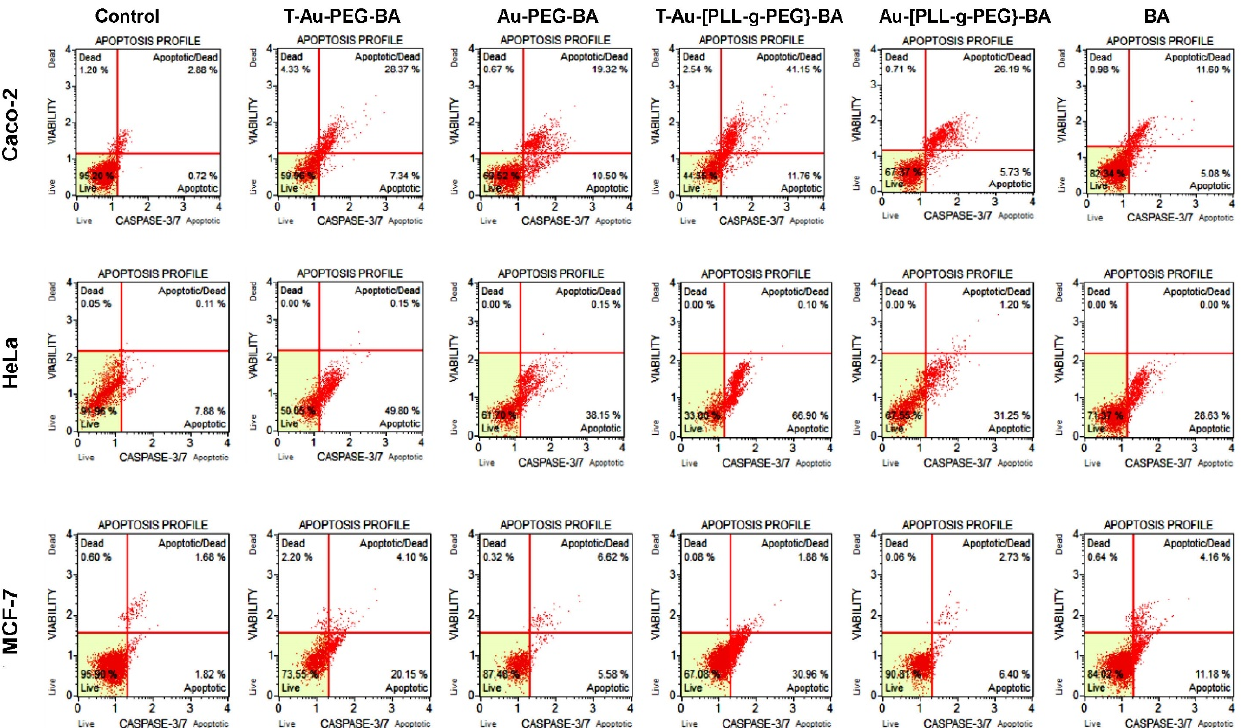
Figure 10. Cytographs showing the effect of targeted and untargeted nanocomplexes on caspases 3 and 7 in Caco-2, HeLa and MCF-7 cells. Au-PEG-BA; Au-[PLL-g-PEG]-BA = untargeted n nanocomplexes, T-Au-PEG-BA; T-Au-[PLL-g-PEG]-BA = targeted nanocomplexes, and BA = free drug. Top left quadrat: cell death by non-apoptotic mechanisms; top right quadrat: cell death by caspase dependent apoptosis; lower left quadrat: Live cells; lower right quadrat: cells undergoing caspase dependent apoptosis.